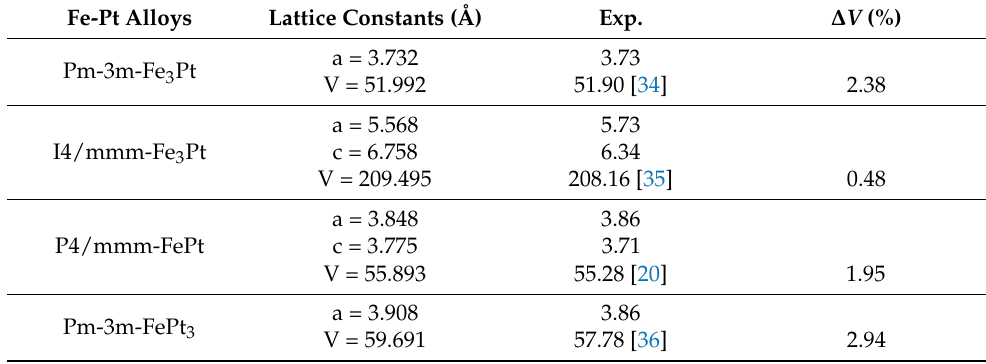
Table 1. Calculated and experimental structural lattice constants for the Fe-Pt alloys. Fe-Pt Alloys